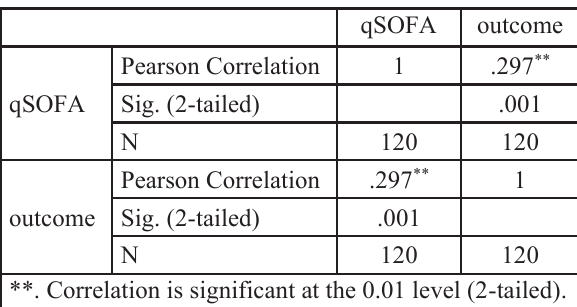
Table-3: Pearson Correlation of qSOFA with